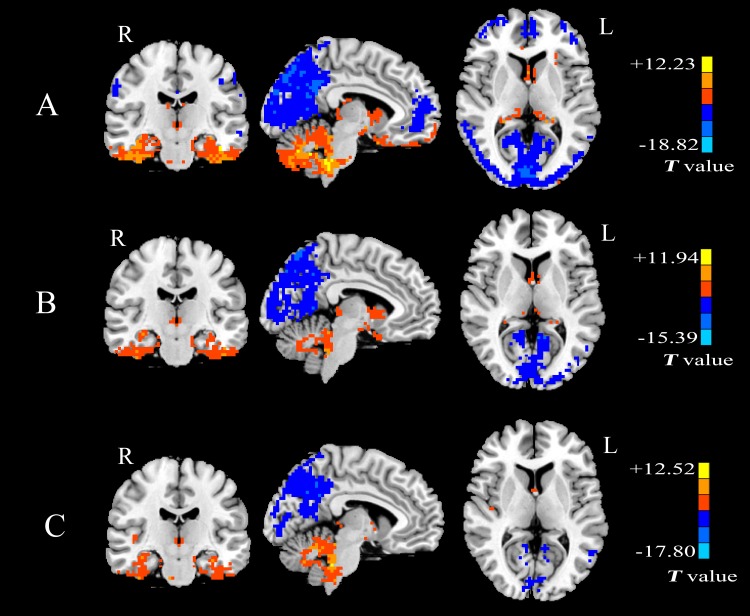
Results of the one sample t-test for Freq map across the three groups.(A) healthy controls. (B) patients with left mTLE. (C) patients with right mTLE. One sample t-test, p < 0.05, voxels > 80, with FDR correction (Q value < 0.01). Color scale indicates the high Freq value.